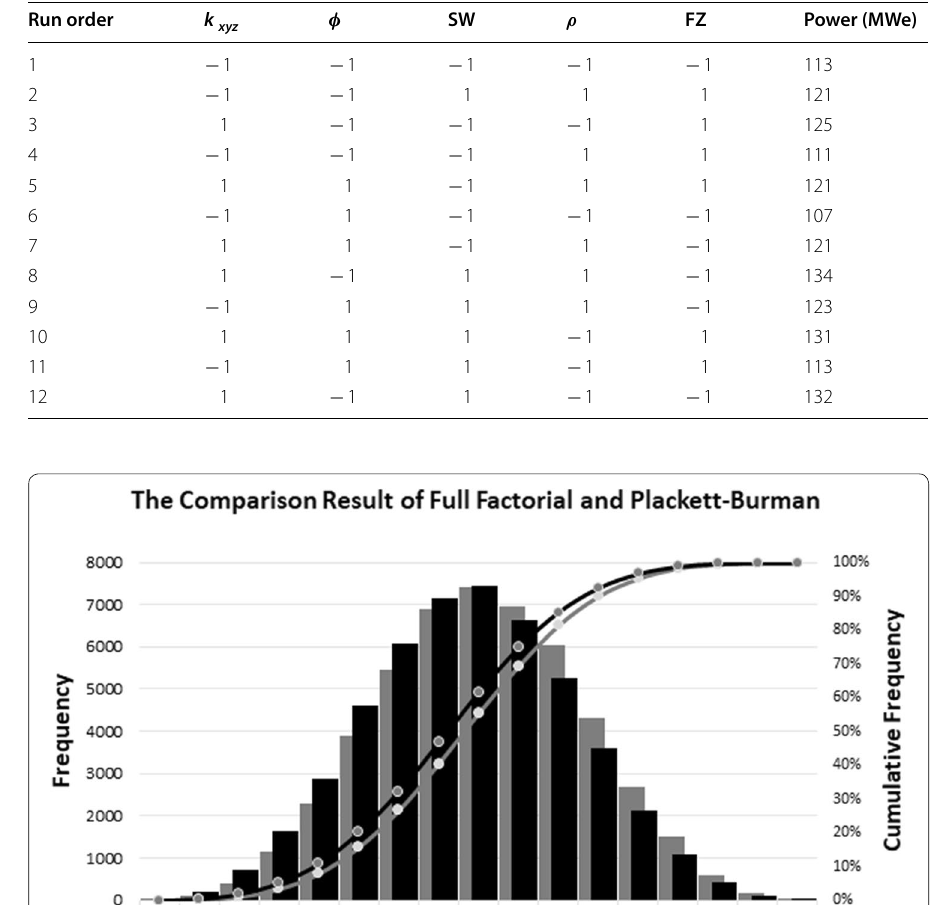
Table 6 K–TB reservoir numerical model results to the Plackett–Burman designed simulation experiments